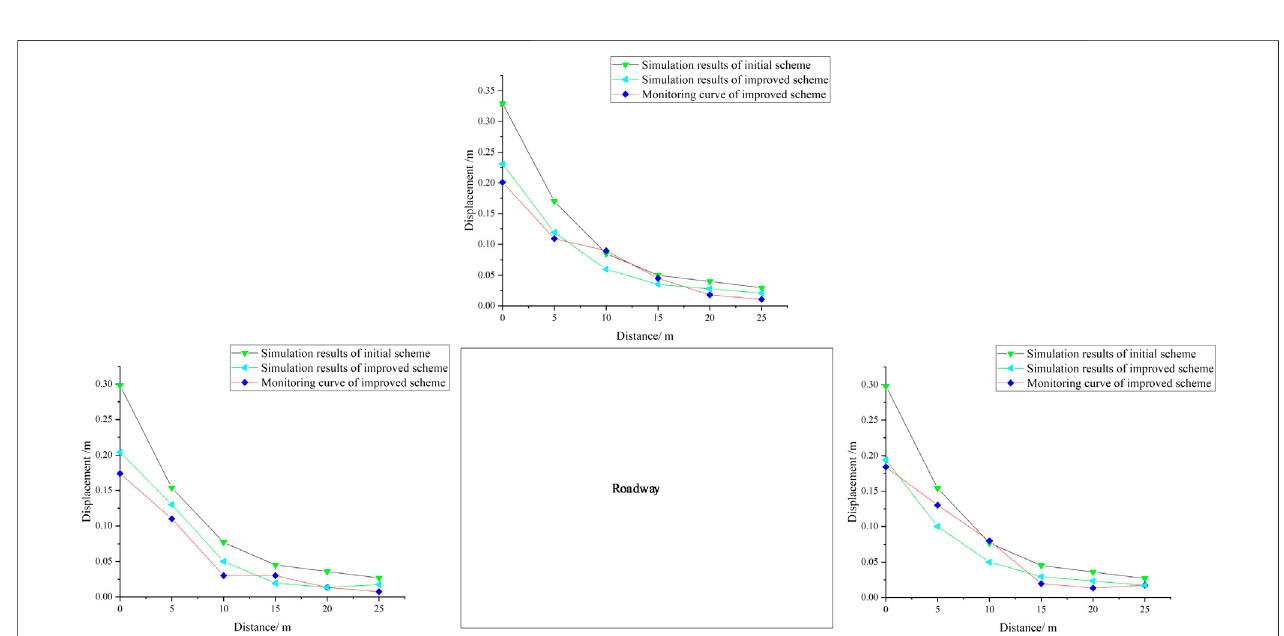
FIGURE 14 | Comparison of two support schemes.